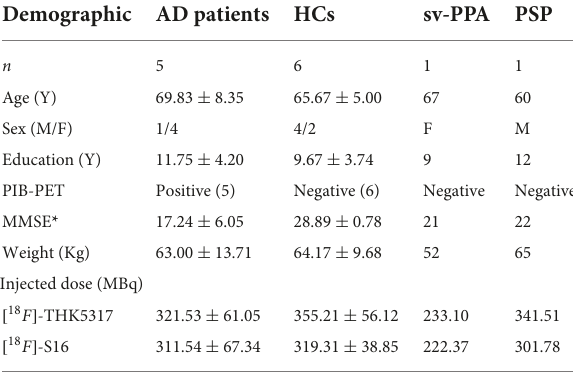
TABLE 1 Clinical and demographic characteristics of all